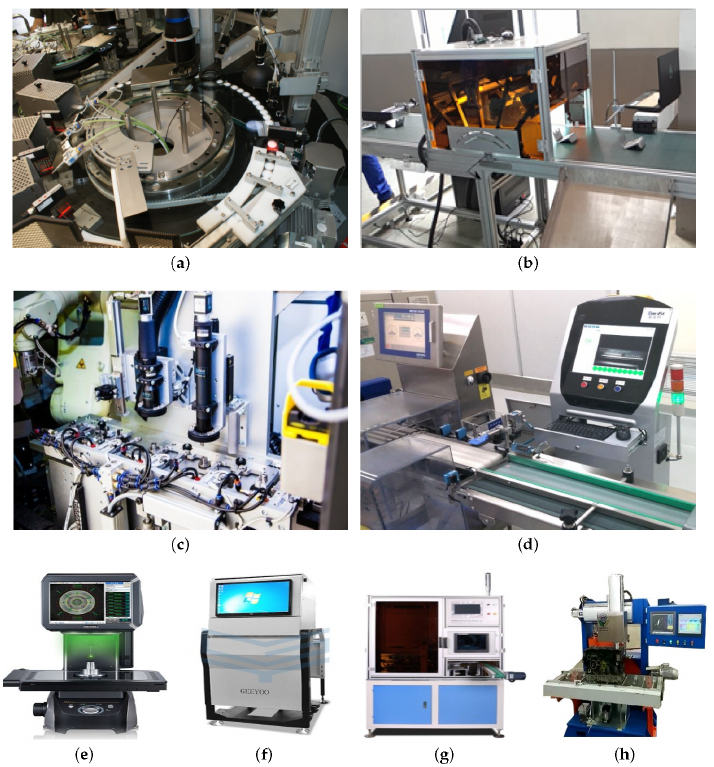
Figure 3. Types of defect-detection equipment: ( a ) Rhein–Nadel automation (RNA) glass defect-detection system [156] ( b ) Visual detection system for defects of EvenFit components [157] ( c ) Rhein–Nadel automated detection system for defects in mechanical parts [158] ( d ) The visual detection system of the EvenFit capsule [159] ( e ) KEYENCE product size measuring instrument [160] ( f ) AVI soldering appearance inspection machine [161] ( g ) Hardware and workpiece visual measurement equipment [162] ( h ) ET-F1 engine cylinder bore eddy current detector